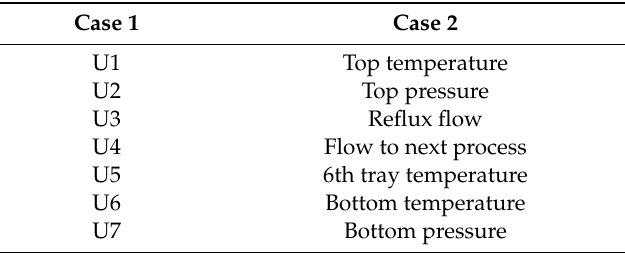
Figure 4. Debutanizer column process. Table 2. Auxiliary variables for the debutanizer column process.